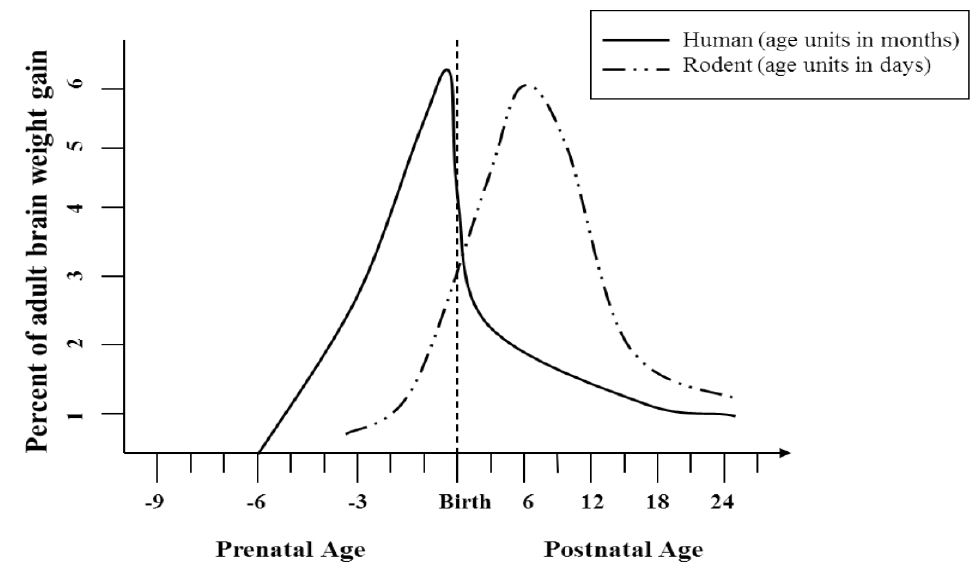
Figure 1. Brain growth spurt in humans and